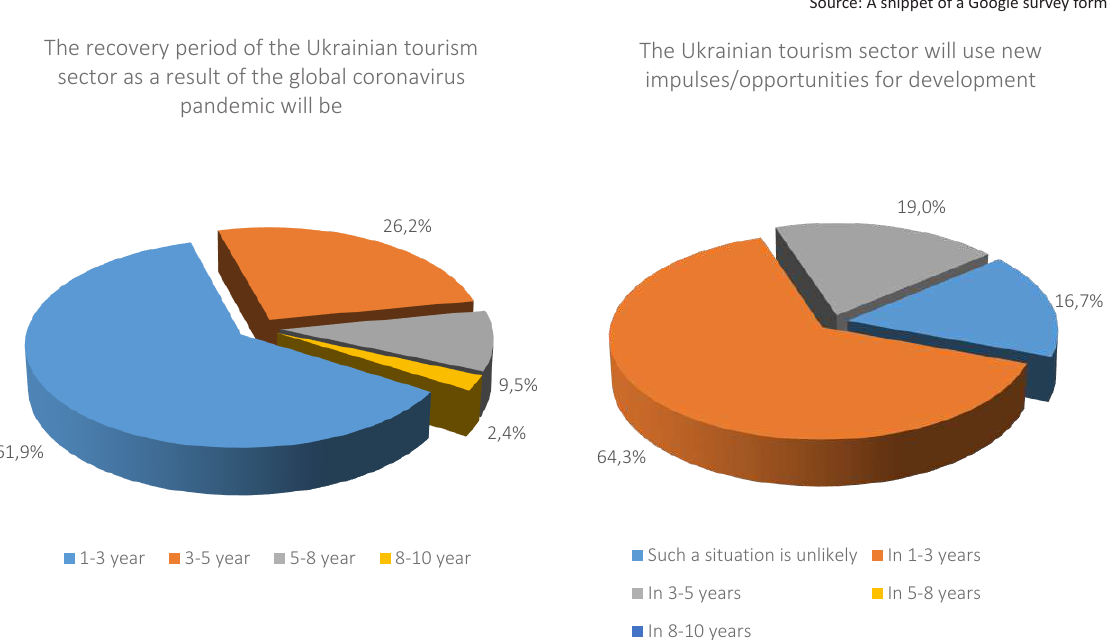
Figure 3. Generalization of the experts’ answers in a foresight study on the restoration of Ukraine’s tourism sector according to the consequences of